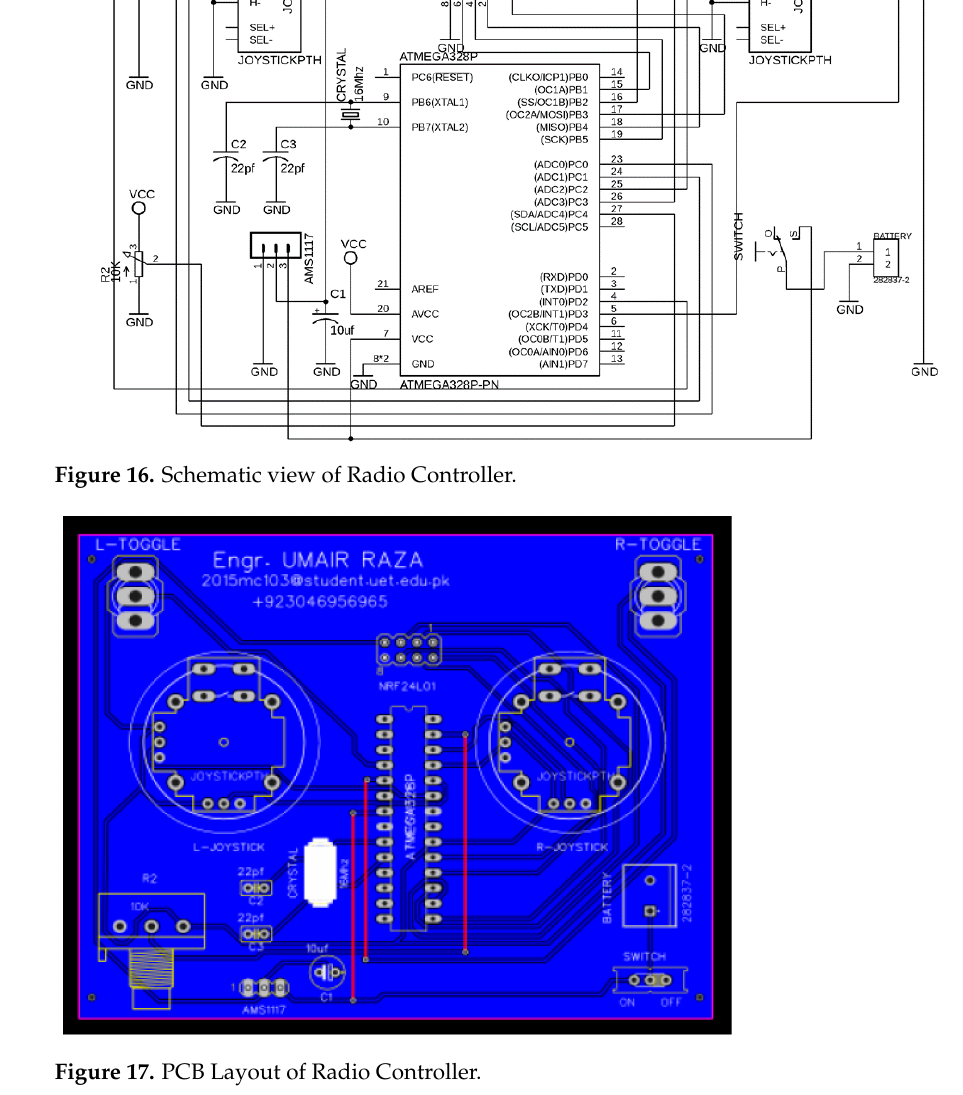
Figure 17. PCB Layout of Radio Controller.